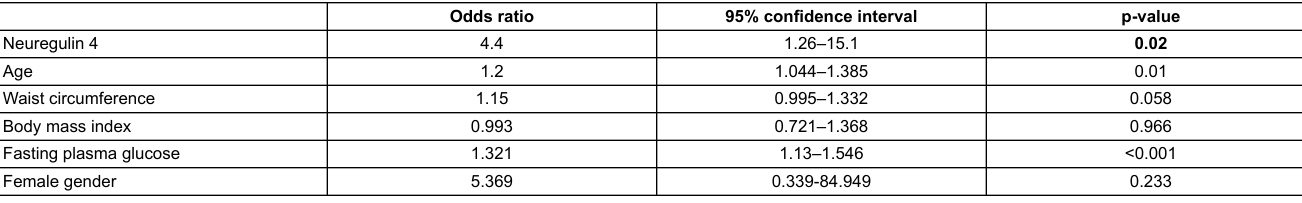
Table 3: Assessment of variables in the study population with binary logistic